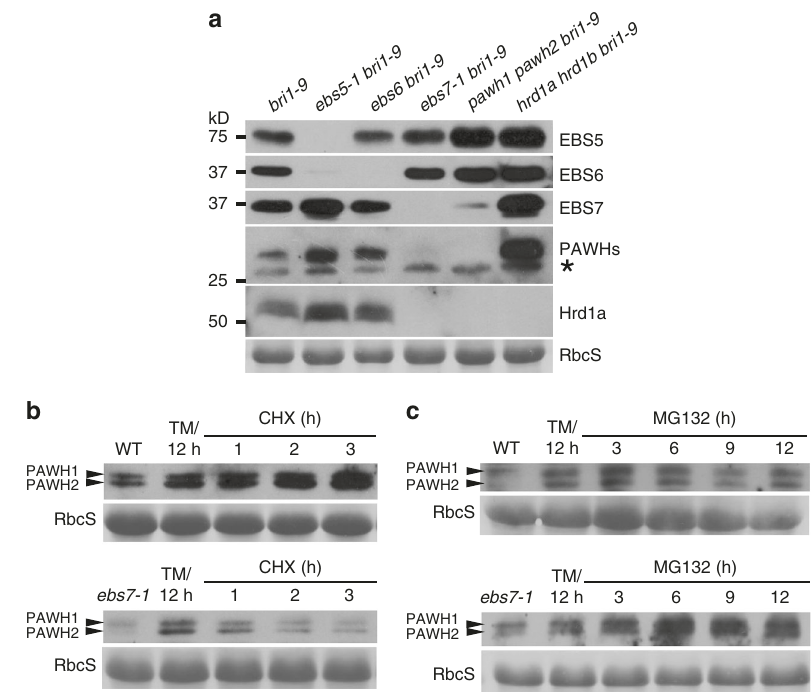
Fig. 5 Impact of ERAD mutations on the stability of EBS7, PAWHs, and Hrd1a. a Immunoblot analysis of the protein abundance of EBS5, EBS6, EBS7, PAWH1/2, and Hrd1a in 4-week-old seedlings of various ERAD mutants. Asterisk indicates a non-speci fi c band. b , c Immunoblot analysis of the protein abundance of PAWHs. Total proteins extracted from 10-day-old seedlings treated with 5 μ g/mL TM for 12 h followed by treatment with 180 μ M CHX ( b ) or 80 μ M MG132 ( c ) for different durations were separated by SDS-PAGE and analyzed by immunoblotting with anti-PAWH antibody. In a – c , the RbcS- labeled strips show the Ponceau Red-stained RbcS band and were used as the loading controls for the experiments. Source data are provided as a Source data fi